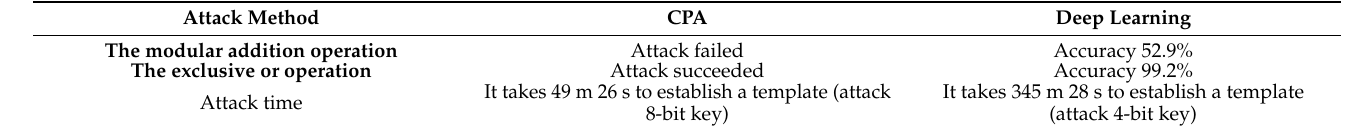
Table 1. Attack results using different attack